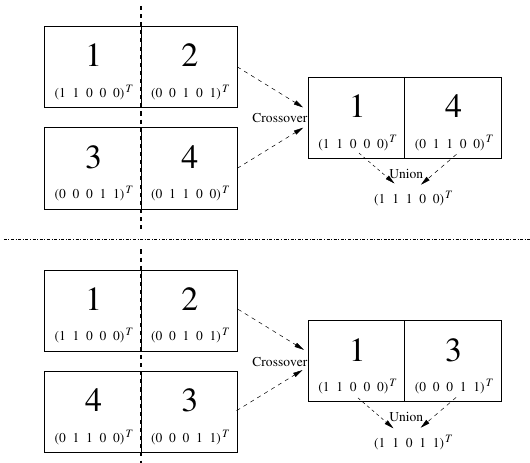
Figure 5. Effect of rearranging genes to match similar columns in the example from Figure 1.